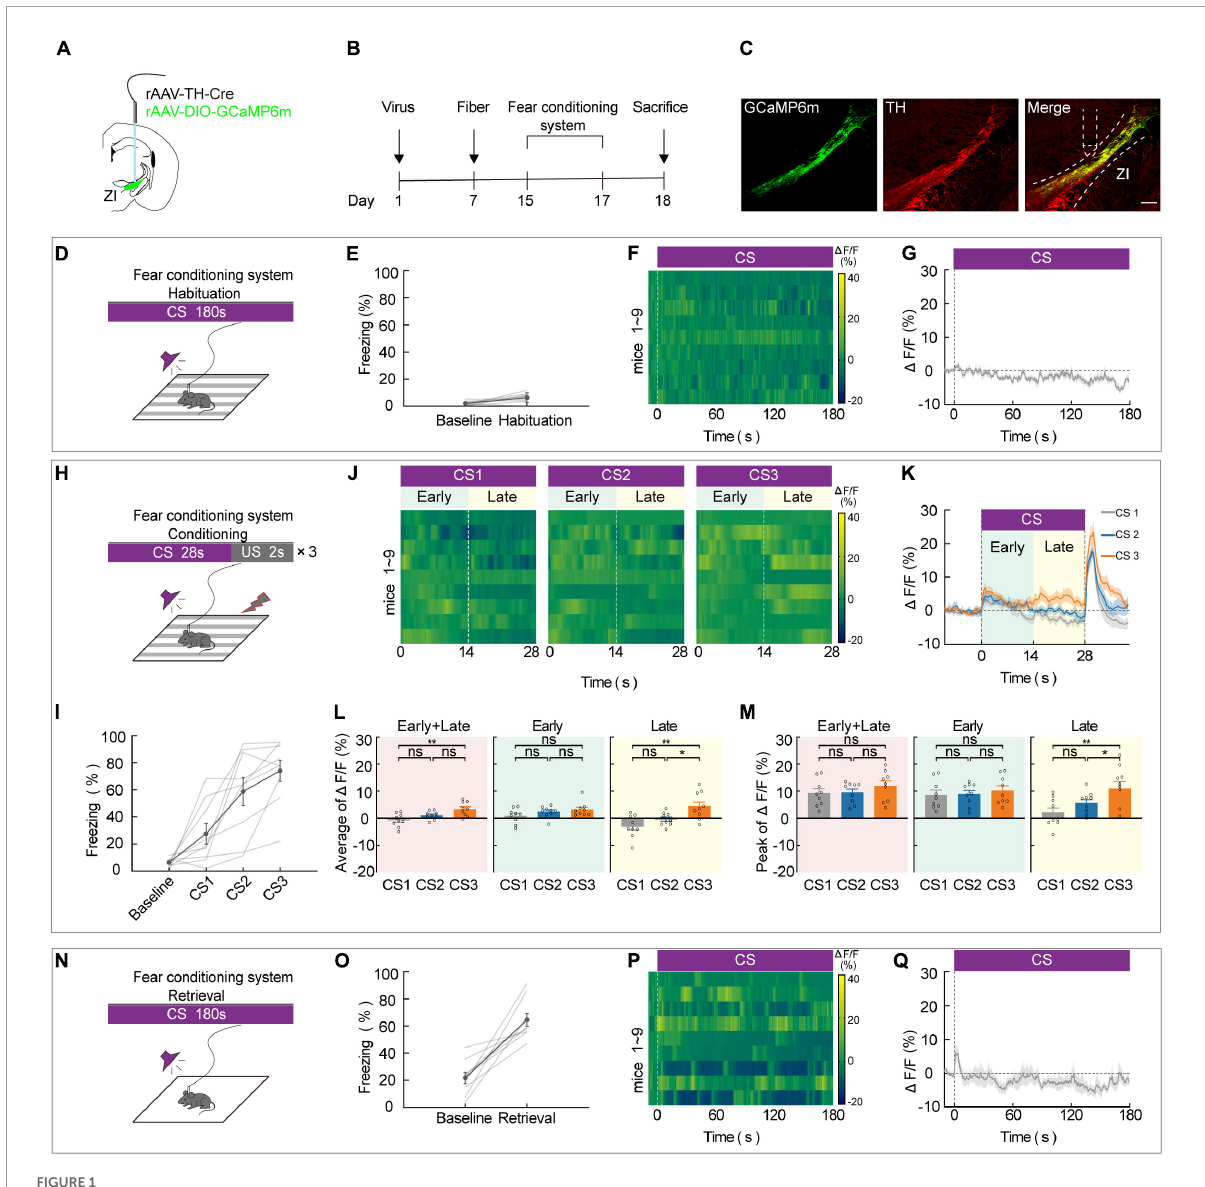
FIGURE1 ZI TH + neurons contribute to the aversive expectation in the late stage of CS. (A) Schematic representation of the virus injection and optic fiber implantation. (B) Experimental protocol timeline. (C) Representative image of GCaMP6m expression in the ZI TH-positive cells dominantly; GCaMP6m is shown in green, TH + is shown in red and co-expressed cells are shown in yellow. Scale bar, 500 µ m. (D-G) Habituation day paradigm. (D) Behavioral methodology. (E) Freezing behavior during habituation day. (Mean ± SEM. n = 9). (F) Representative heatmaps of fluorescence aligned to the CS delivery (time point 0) for 9 mice. (G) Mean fluorescence aligned to CS delivery (mean ± SEM n = 9). (H-M) Conditioning phase paradigm. (H) Behavioral methodology. (I) Freezing behavior during conditioning phase. (Mean ± SEM n = 9). (J) Representative heatmaps of fluorescence are aligned with CS1, CS2, and CS3 delivery (time point 0) for 9 mice, respectively, arranged from left to right. 0–14 and 14–28 s named early and late phases of CS. (K) Mean fluorescence aligned to CS delivery in ZI TH + neurons (mean ± SEM n = 9). (L) Mean fluorescence to CS3 higher than CS1 delivery for whole session of CS and late phase of CS, but not early phase of CS (early + late: one-way ANOVA, group: p = 3 × 10 – 3 ; post hoc Sidak’s test, CS1 vs. CS2: p = 0.1162, CS1 vs. CS3: p = 0.0023, CS2 vs. CS3: p = 0.0713; early: one-way ANOVA, group: p = 0.1492; post hoc Sidak’s test, CS1 vs. CS2: p = 0.3762, CS1 vs. CS3: p = 0.1602, CS2 vs. CS3: p = 0.4810; late: one-way ANOVA, group: p = 2.6 × 10 – 3 ; post hoc Sidak’s test, CS1 vs. CS2: p = 0.2081, CS1 vs. CS3: p = 0.0023, CS2 vs. CS3: p = 0.0340; mean ± SEM n = 9). (M) Peak fluorescence to CS3 higher than CS1 delivery for late phase of CS, but not early phase of CS (early + late: one-way ANOVA, group: p = 0.4555; post hoc Sidak’s test, CS1 vs. CS2: p = 0.9134, CS1 vs. CS3: p = 0.5939, CS2 vs. CS3: p = 0.5939; early: one-way ANOVA, group: p = 0.7558; post hoc Sidak’s test, CS1 vs. CS2: p = 0.9351, CS1 vs. CS3: p = 0.8730, CS2 vs. CS3: p = 0.8730; late: one-way ANOVA, group: p = 2.5 × 10 – 3 ; post hoc Sidak’s test, CS1 vs. CS2: p = 0.1740, CS1 vs. CS3: p = 0.0021, CS2 vs. CS3: p = 0.0393; mean ± SEM n = 9). (N–Q) Retrieval day paradigm. (N) Behavioral methodology. (O) Freezing behavior during the retrieval phase. (Mean ± SEM n = 9). (P) Representative heatmaps of fluorescence aligned to the CS delivery (time point 0) for 9 mice. (Q) Mean fluorescence aligned to CS delivery (mean ± SEM n = 9). ns not significant, * P ≤ 0.05, ** P ≤